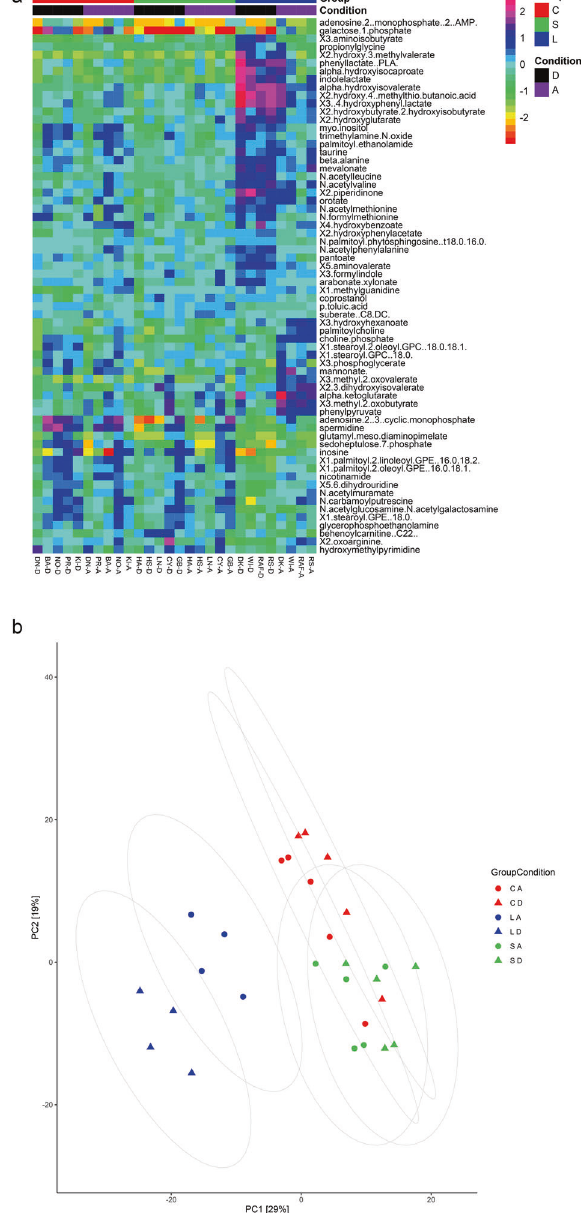
Fig. 5 Effects of chronic excessive alcohol drinking on fecal metabolome. a Heatmap showing those metabolites ( N = 63), out of the 534 identi fi ed, which achieved statistical signi fi cance (FDR-adjusted p <0.01) in the group x condition interaction in the linear mixed models (LMMs). The long-term alcohol drinking group (L) is depicted in blue, the short-term alcohol drinking group (S) in green, and the control group (C) in red. The drinking condition (D) is depicted in black and the abstinence condition (A) in purple. b Score plot between the selected fi rst two principal components (PCs) based on the output from the linear mixed models (LMMs). Group L is depicted in blue, group S in green, and group C in red. Triangles represent the drinking condition for each group (LD, SD, CD), circles represent the abstinence condition for each group (LA, SA, CA). Percent explained variance is reported in brackets on fi rst ( x axis) and second ( y axis) principal component in the L and S groups compared with the C group, similarly to a study in alcohol-dependent individuals with high intestinal permeability [5]. Conversely, a study in male macaques reported an increase of Prevotellaceae following chronic alcohol self-